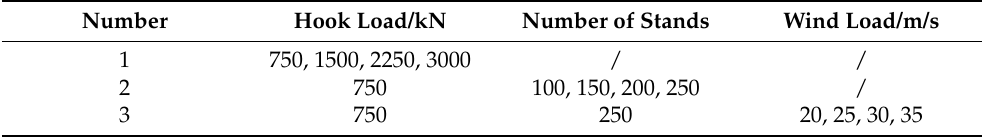
Table 2. The schematic program of numerical studying of derrick under complex